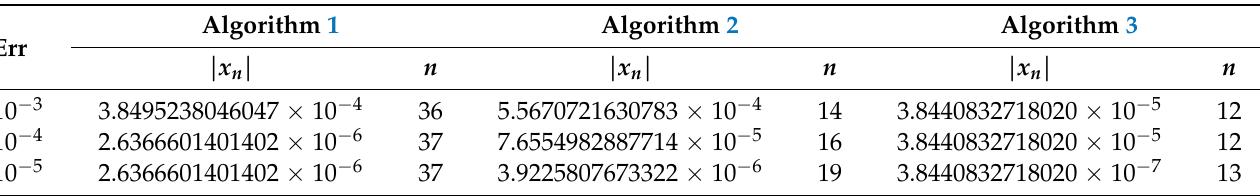
Table 2. Numerical results for Example 4 in Case